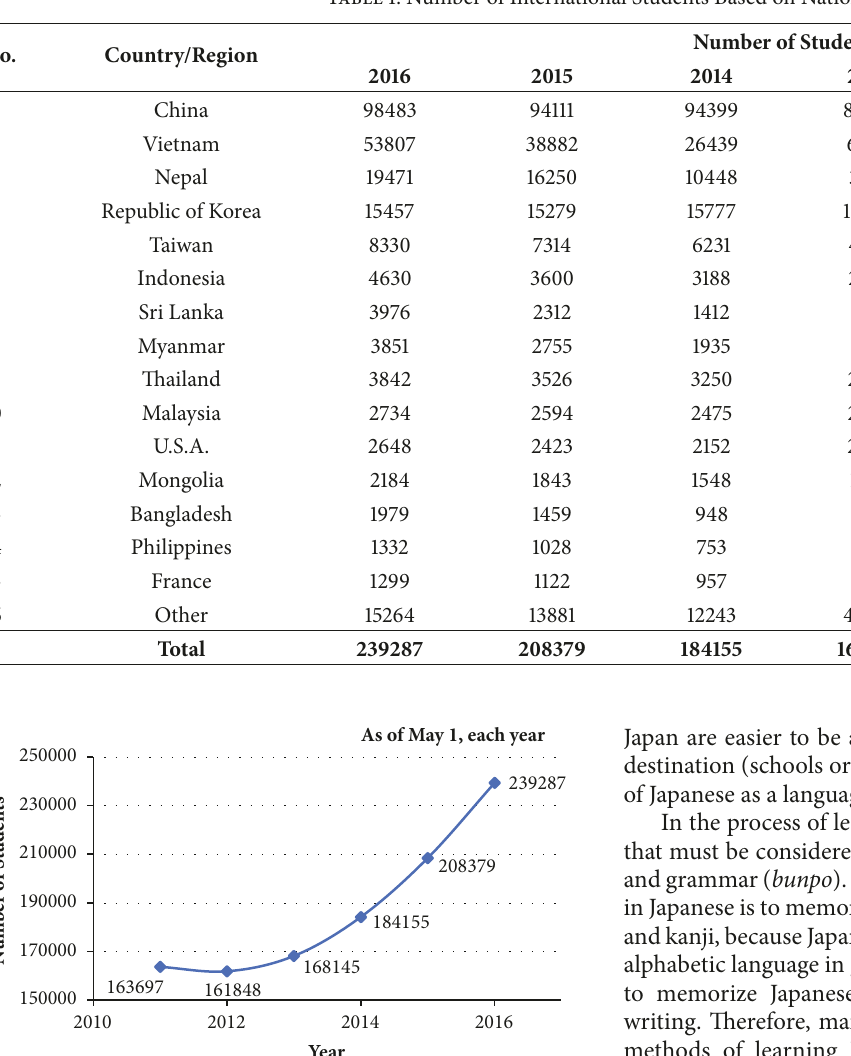
Figure 1: Movement of number of international students in Japan from